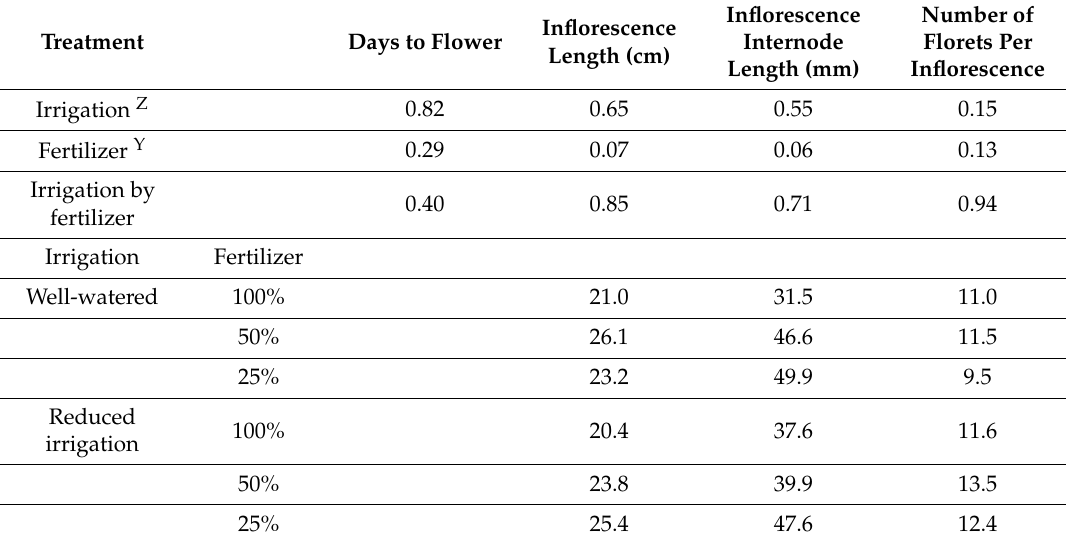
Table 2. Days to flower, inflorescence length, inflorescence internode length, and number of florets per inflorescence for